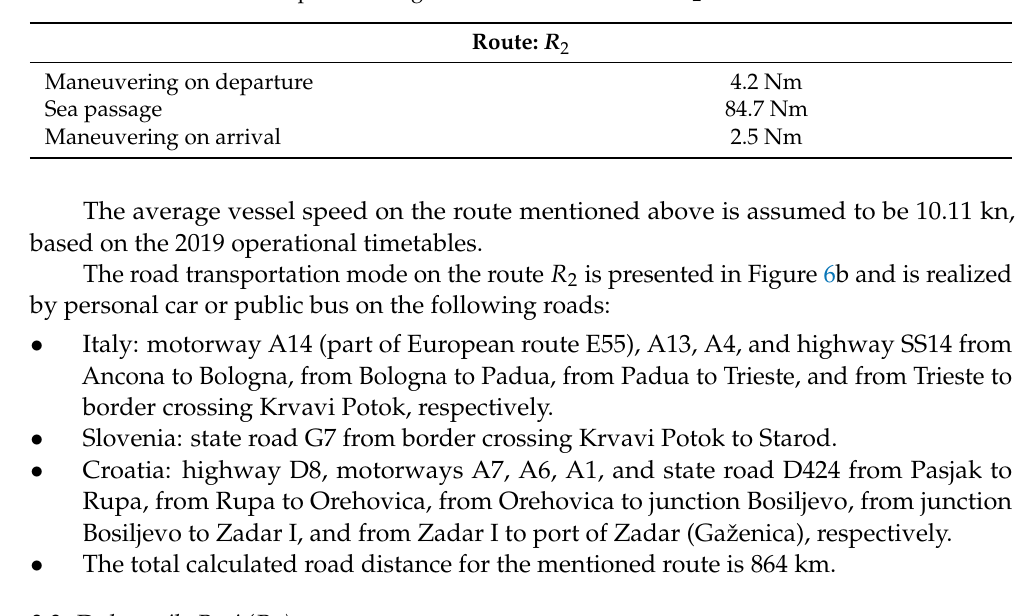
Figure 6. Route 𝑅 (cid:2870) : ( a ) maritime transportation; ( b ) road transportation. Table 12. Distances in the specific navigation modes on the route 𝑅 2 .